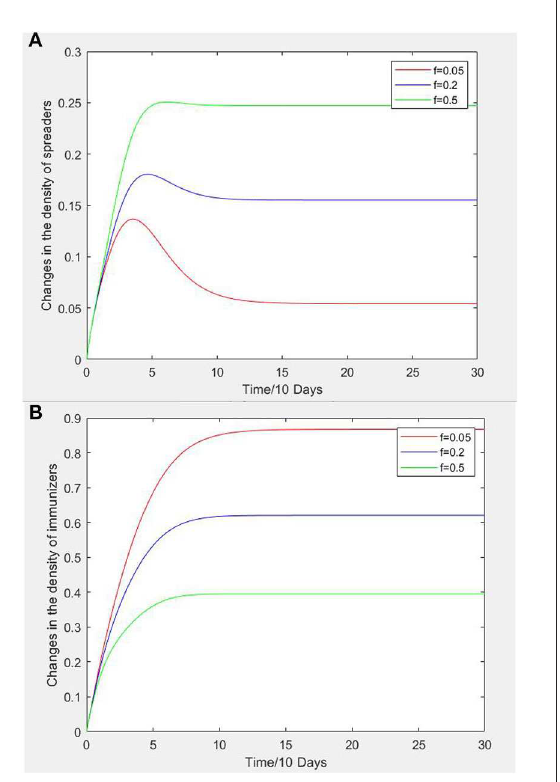
FIGURE5 (A) Variation curves of network average degree vs. infectors density. (B) Variation curves of network average degree vs. recovered persons density.